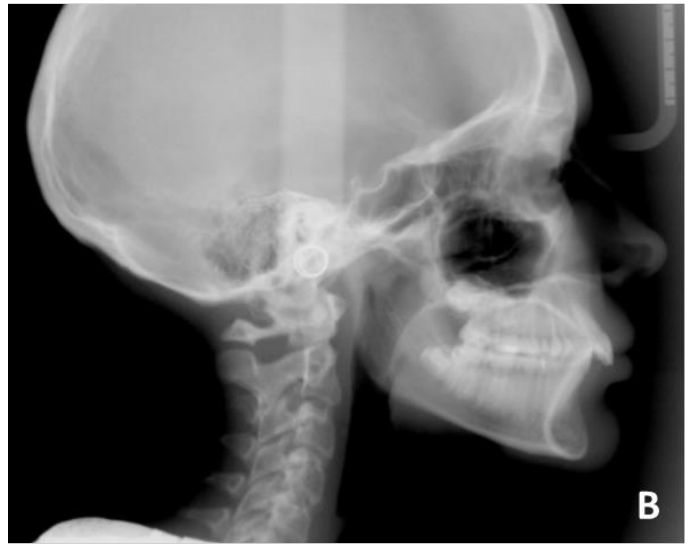
Figure 16. Pre-treatment radiographic of case number 2: ( A ) orthopantomography; ( B ) lateral cephalogram.